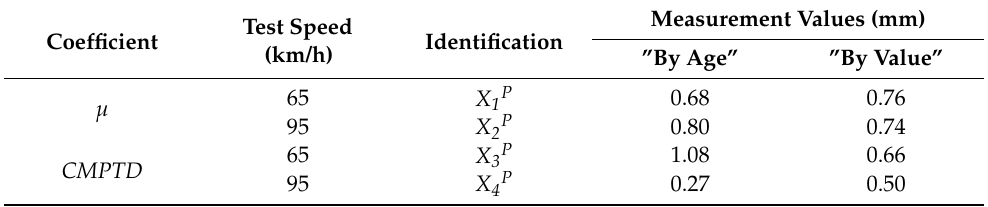
Table 6. Field tests results for asphalt concrete—model I (two speeds